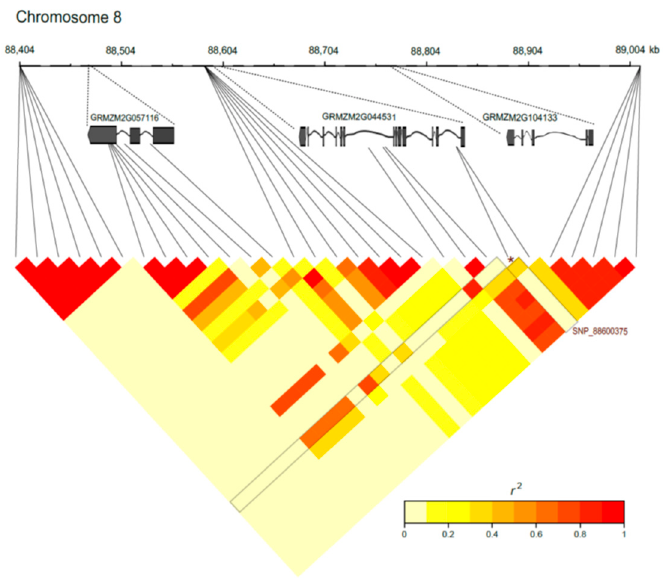
Figure 5. Linkage disequilibrium in a 609.6 kb region within the bin 8.03 of the chromosome 8. The black lines represent each SNP and the asterisks depict the most significant SNP of this region, SNP S8_88600375, for root length under low-P conditions. The positions of the predicted genes GRMZM2G057116 (WRKY member), GRMZM2G044531 (AGC kinase) and GRMZM2G104133 are